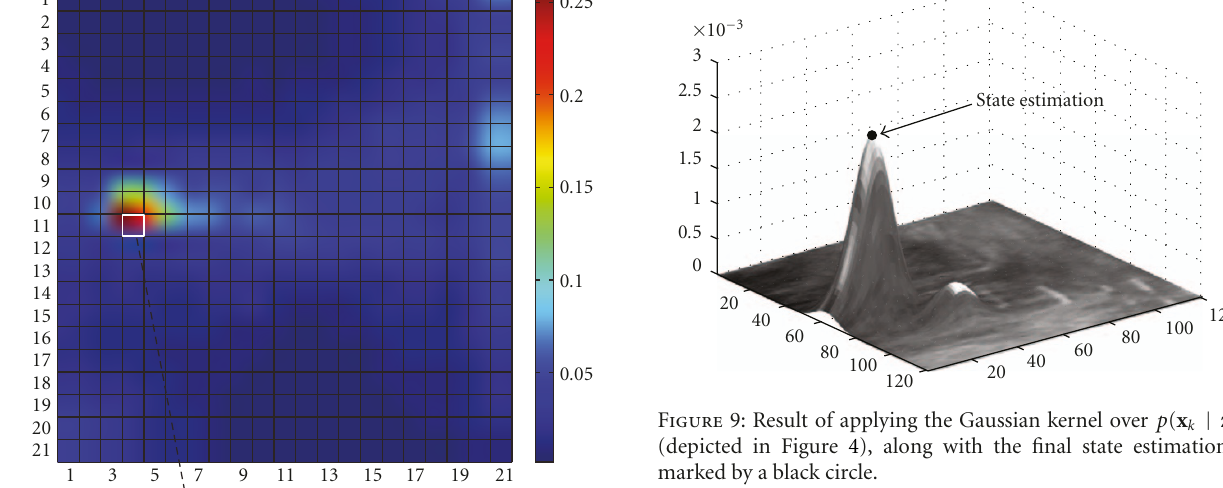
, i = 1, ... ,441 } , which roughly approxi- k